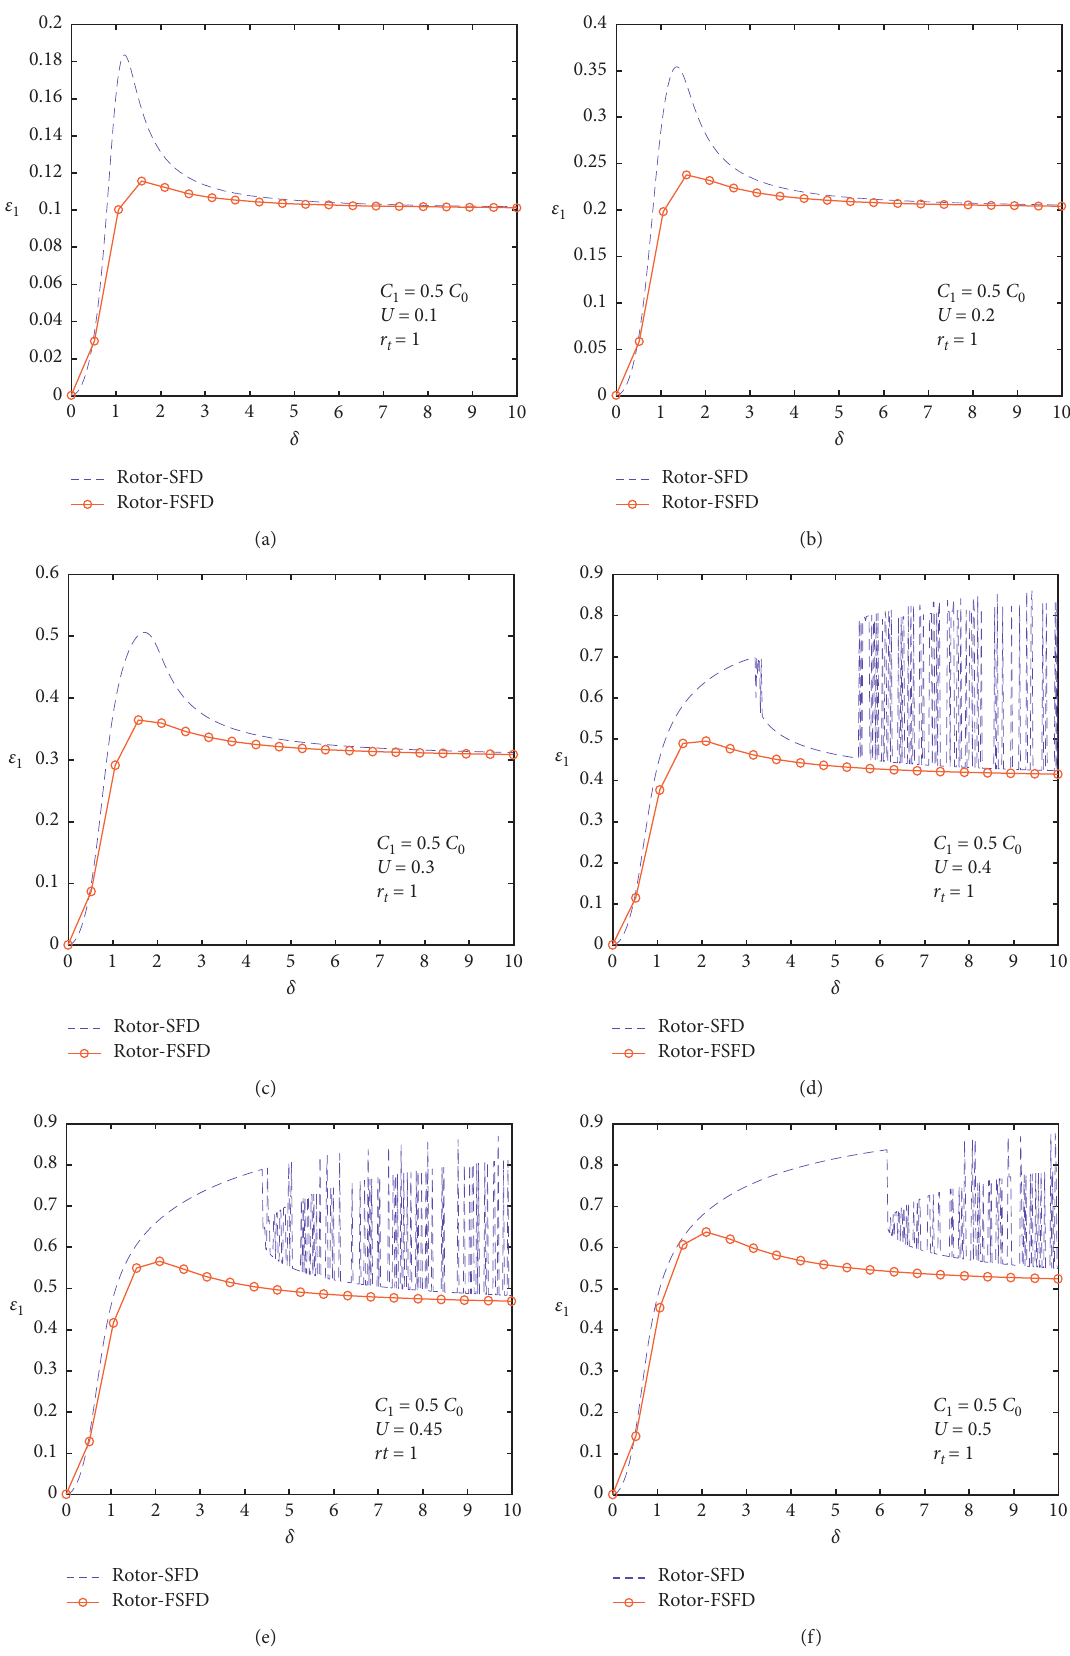
Figure 8: The vibration mitigation characteristic of DCSFD vs. SFD: (a) U � 0 . 1; (b) U � 0 . 2; (c) U � 0 . 3; (d) U � 0 . 4; (e) U � 0 . 45; (f) U � 0 .